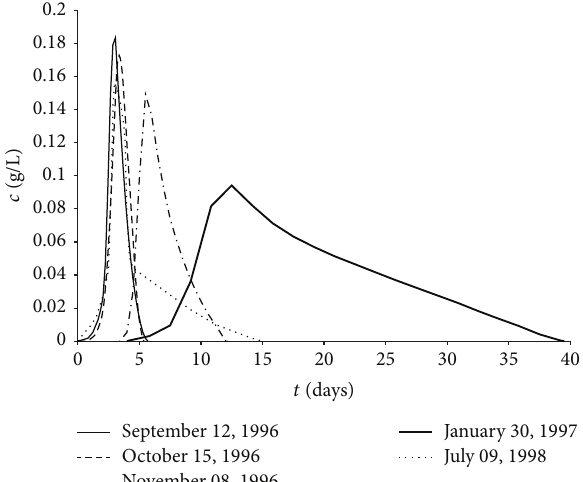
Figure 5: Experimental breakthrough curves for the considered tracer